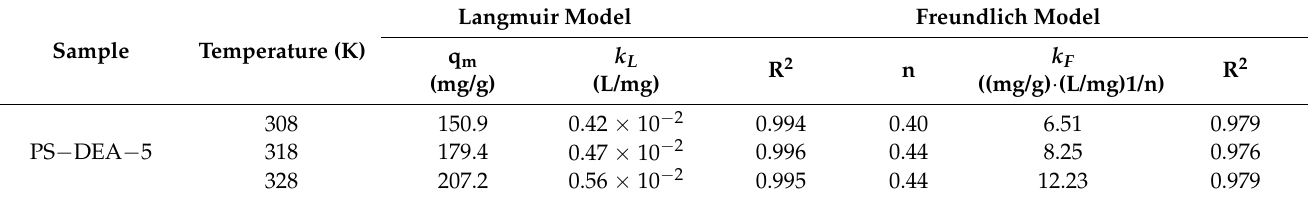
Table 4. Thermodynamic parameters of CPCA adsorption on PS − DEA − 5.